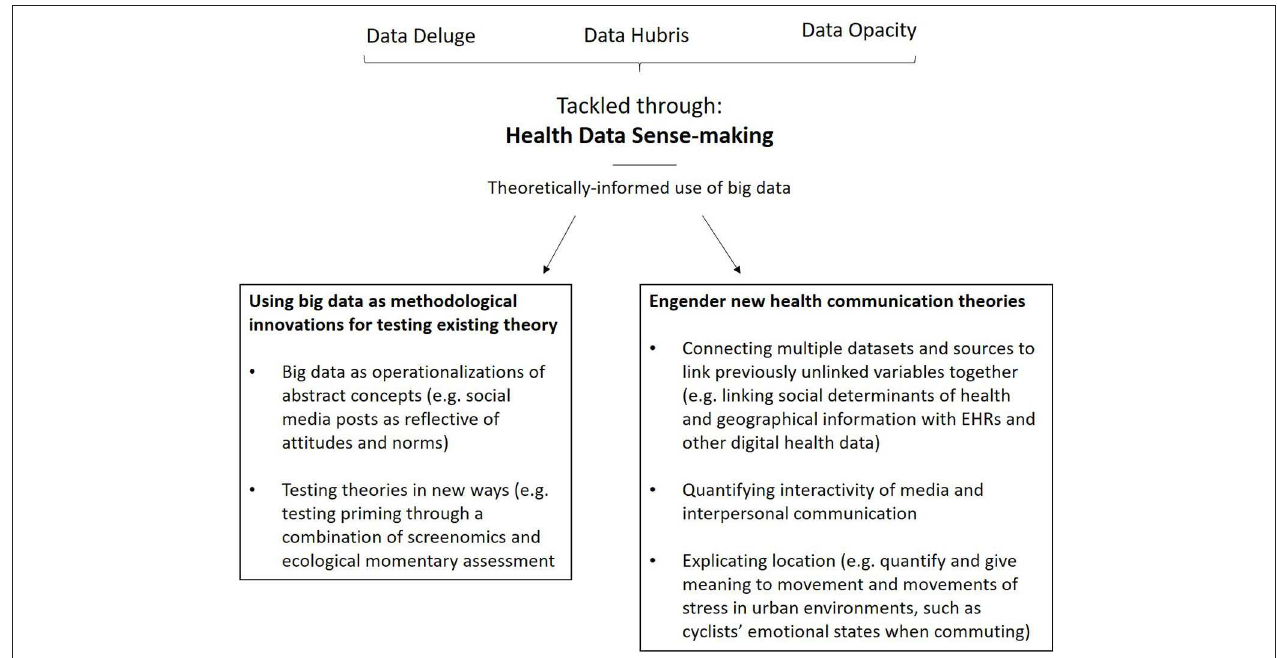
FIGURE 3 | Overview of health data